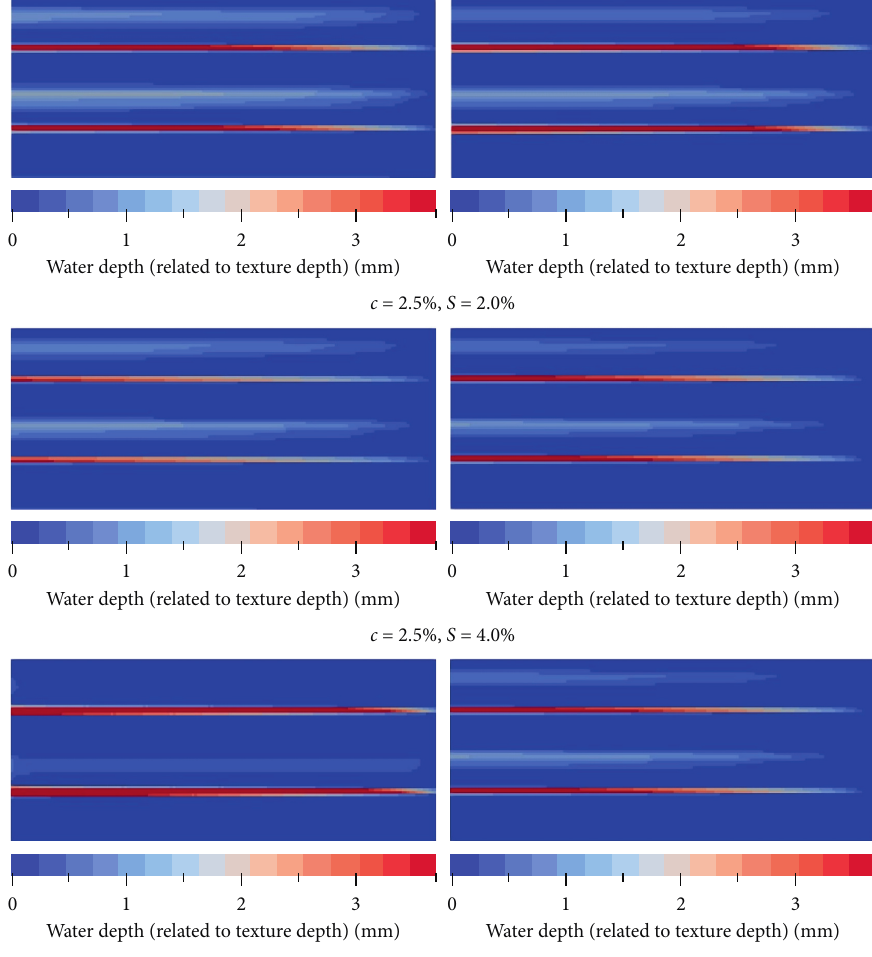
Figure 12: Example 5: effect of texture roughness (MTD) on the drainage of a pavement surface with ruts (rut depth and geometry after 30 years). Left: MTD � 0.4 mm; right: MTD � 0.9